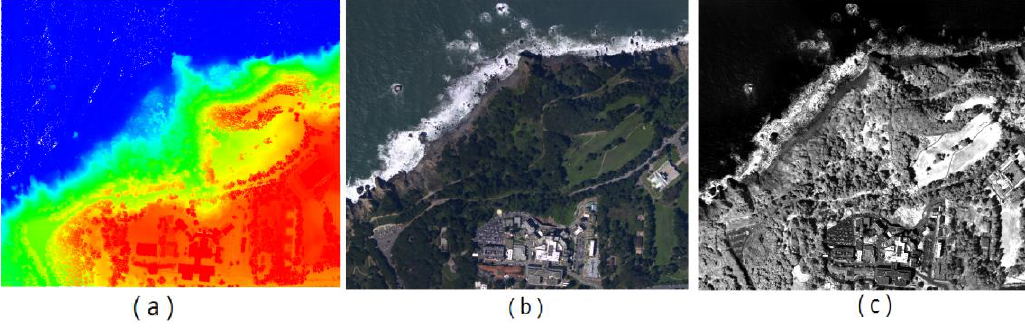
Figure 1. Experiment dataset.